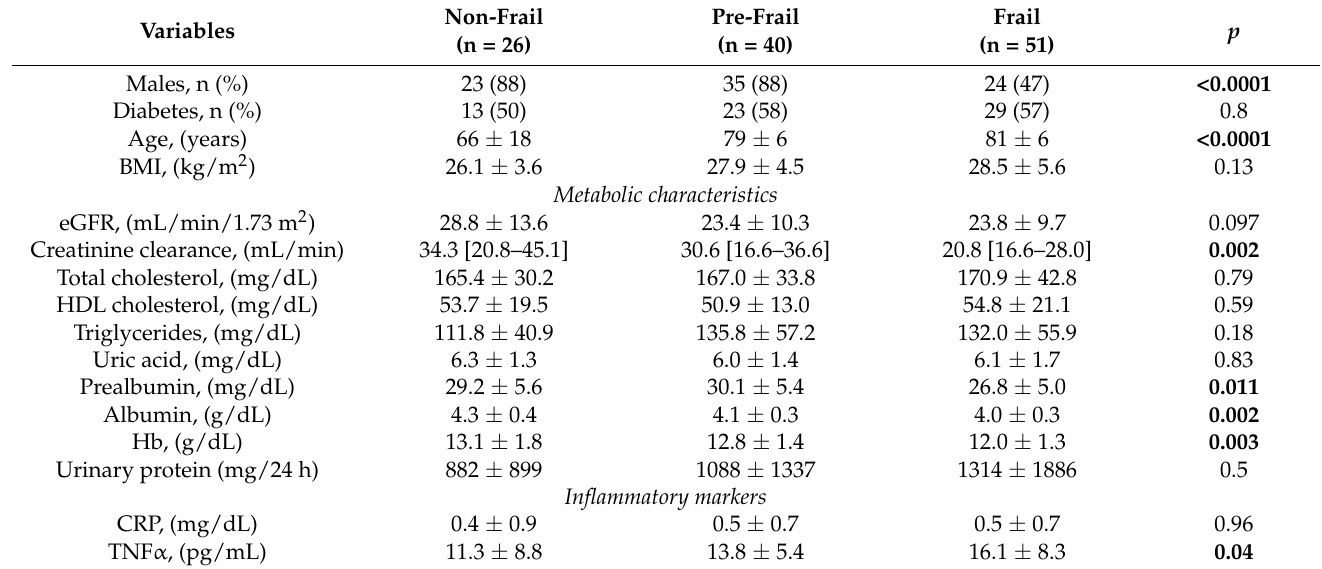
Table 2. Comparison of general characteristics and metabolic parameters between non-frail, pre-frail and frail